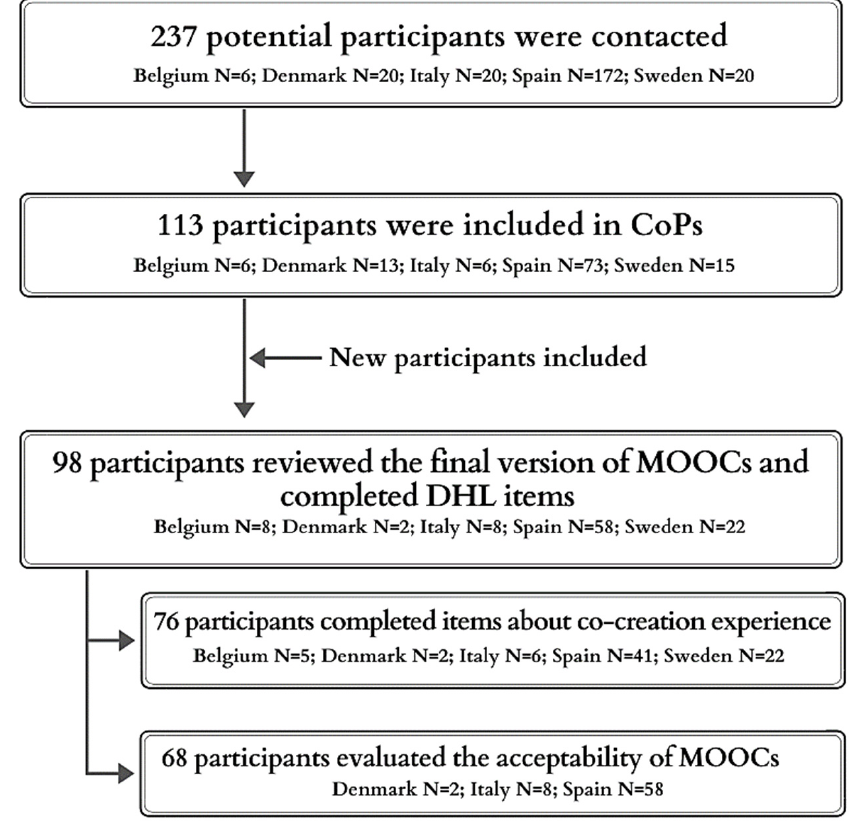
Figure 2. Flow diagram of participation in the co-creation process.